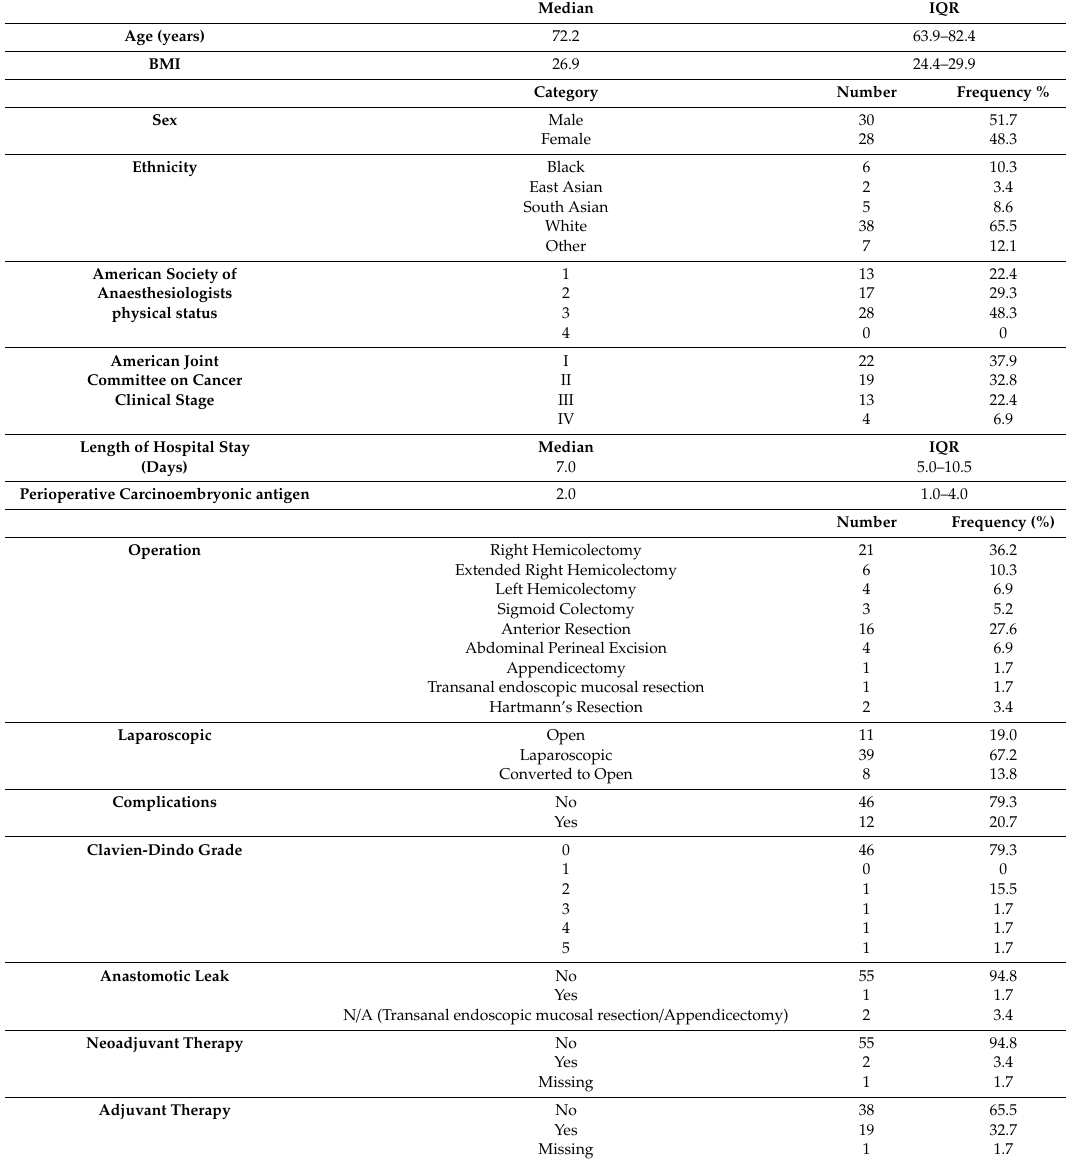
Table 1. Participant demographics and treatment